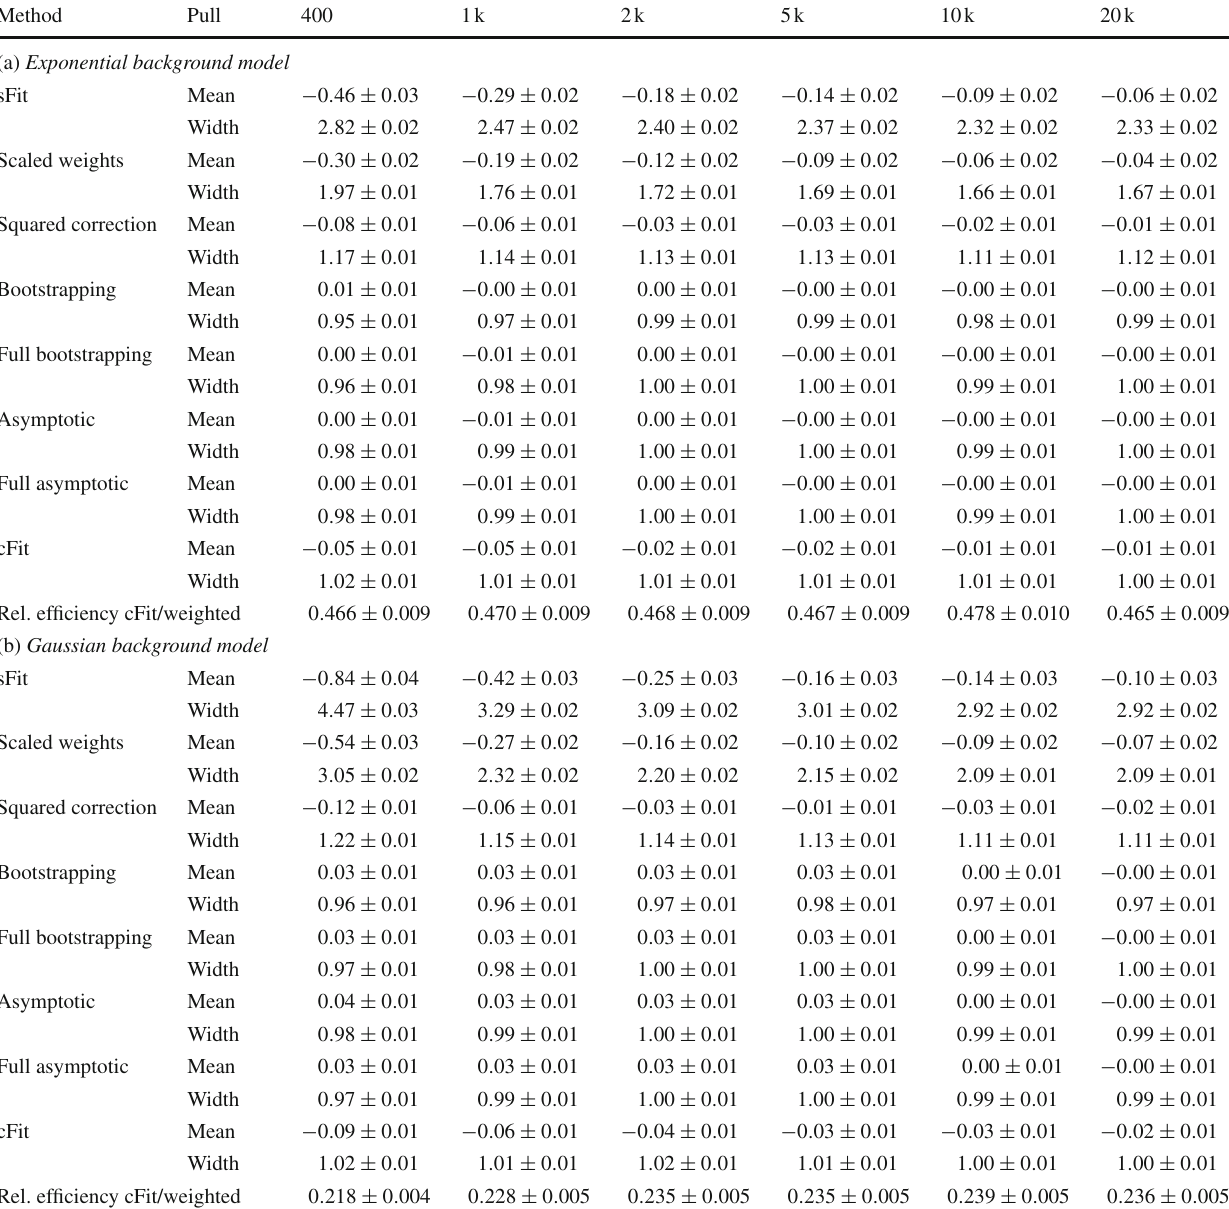
given. The different tables shown correspond to the different back- ground models as specified in Sect. 4. In this case, the mass range [ 5267 , 5467 ] MeV / c 2 is chosen, such that the nuisance parameter α has negligible correlation with the event